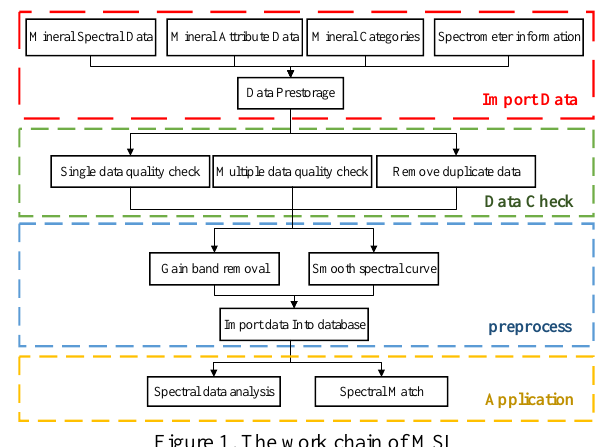
Figure 1. The work chain of MSL